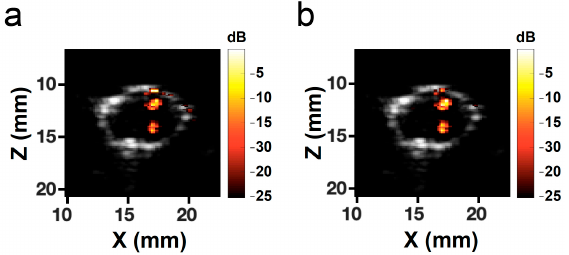
Figure 12. Photoacoustic imaging of ( a ) AuNRs and ( b ) AuNDs. The grayscale images in both panels denote the B-mode images of the cross-section of the hole in the phantom. Color bars represent the intensity of the photoacoustic signals. Locations of the AuNRs and the AuNDs are clearly visible.